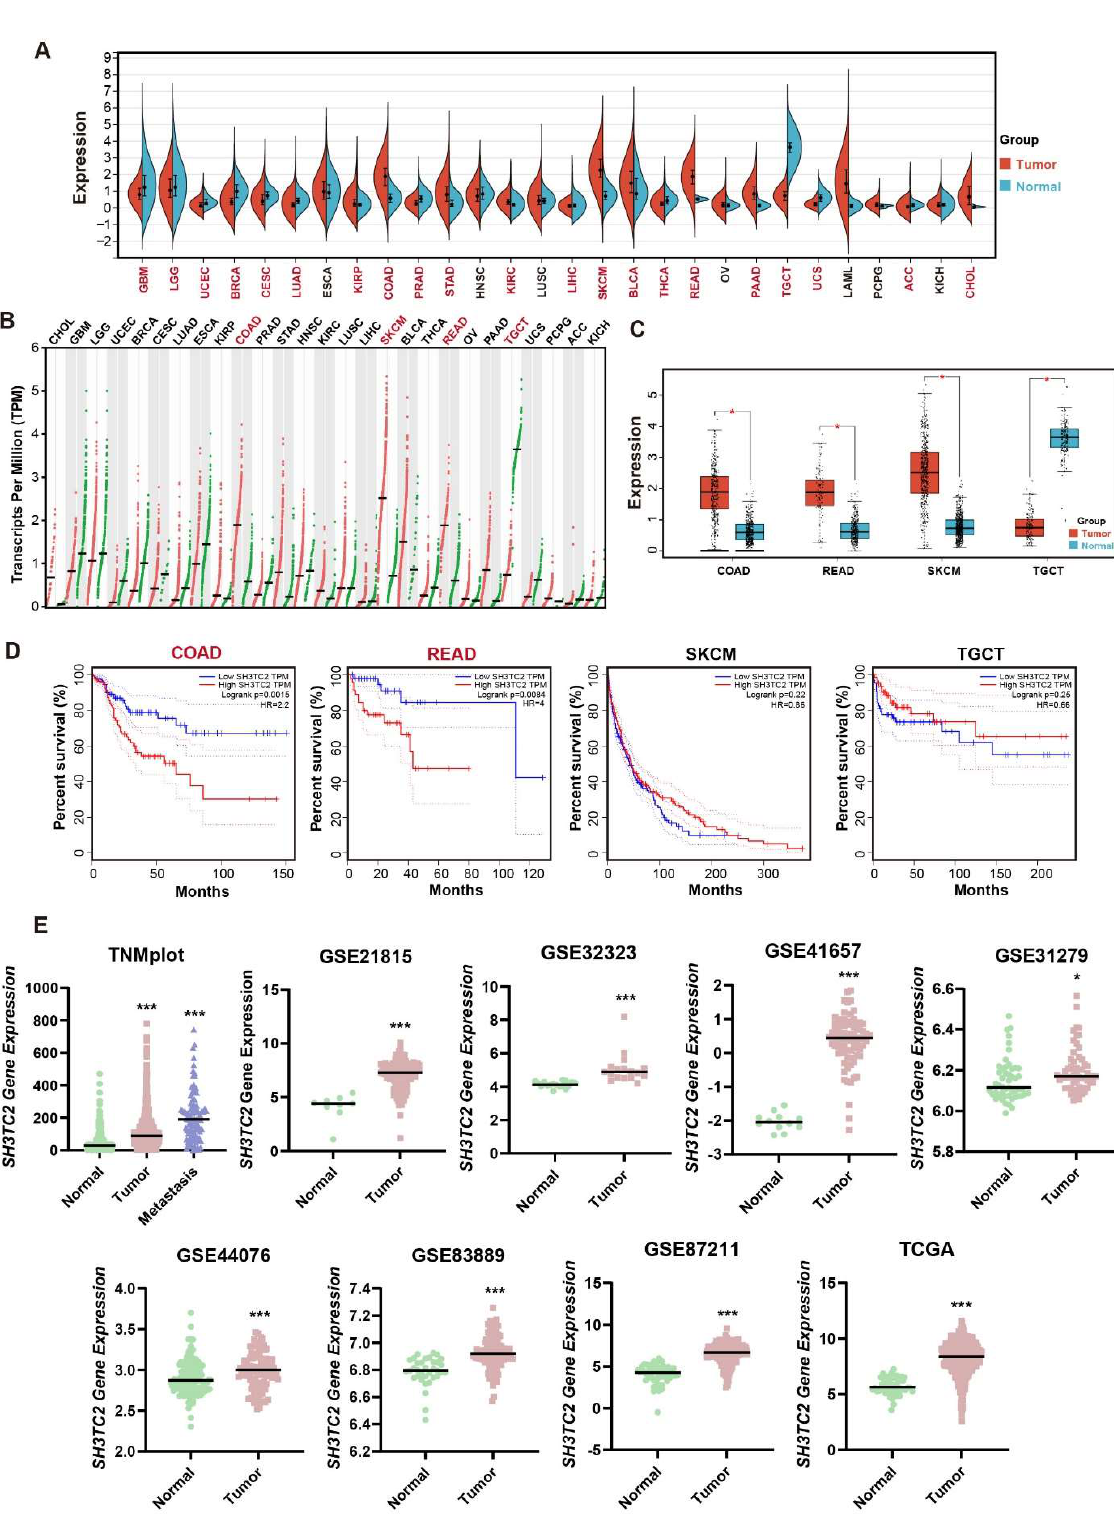
Figure 1. Pan−cancer analysis revealed the expression levels and prognostic value of SH3TC2 in human cancers. ( A ) Comparison of SH3TC2 expression in tumor tissue and normal tissue in the TCGA database. The red−highlighted cancer names indicate significance ( p < 0.05). The abbreviations can be found in Table S2. ( B ) Comparison of SH3TC2 expression in tumor tissue and normal tissue in the GEPIA database. The red−highlighted cancer names indicate that SH3TC2 is differentially expressed in tumor tissue and normal tissue based on screening of the GEPIA and TCGA databases. ( C ) Comparison of SH3TC2 expression in tumor tissue and normal tissue in specific cancers, including COAD, READ, SKCM, and TGCT. Analysis revealed that SH3TC2 is upregulated in